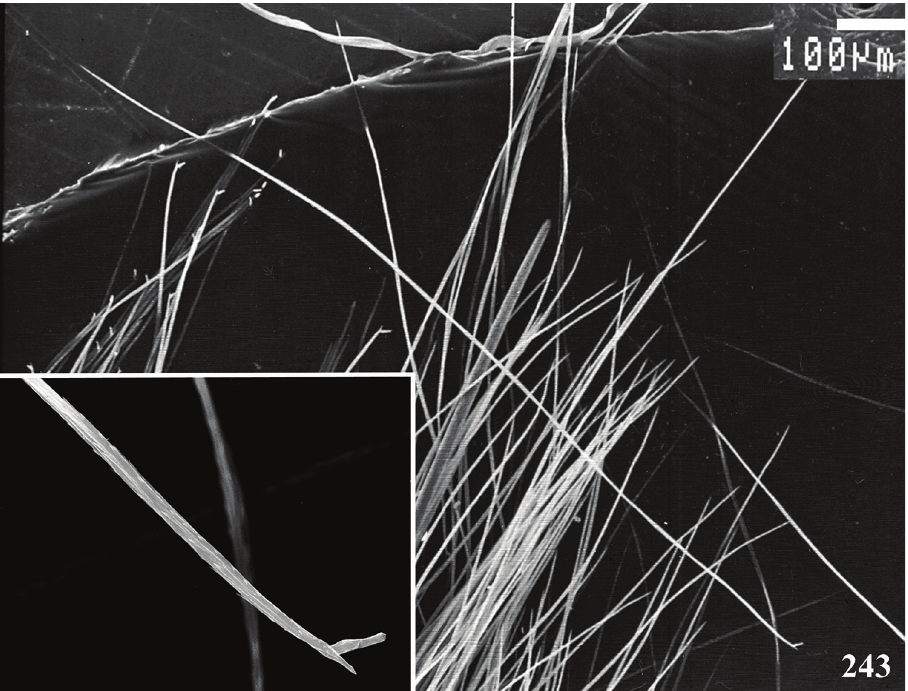
Figure 243. Caribena laeta (C. L. Koch, 1842) comb. n., SEM microphotographs of slender urticating setae type II, with barbs along all its length. Detail: region near stalk, female (MNRJ 06909). Scale bar = 100 μm.